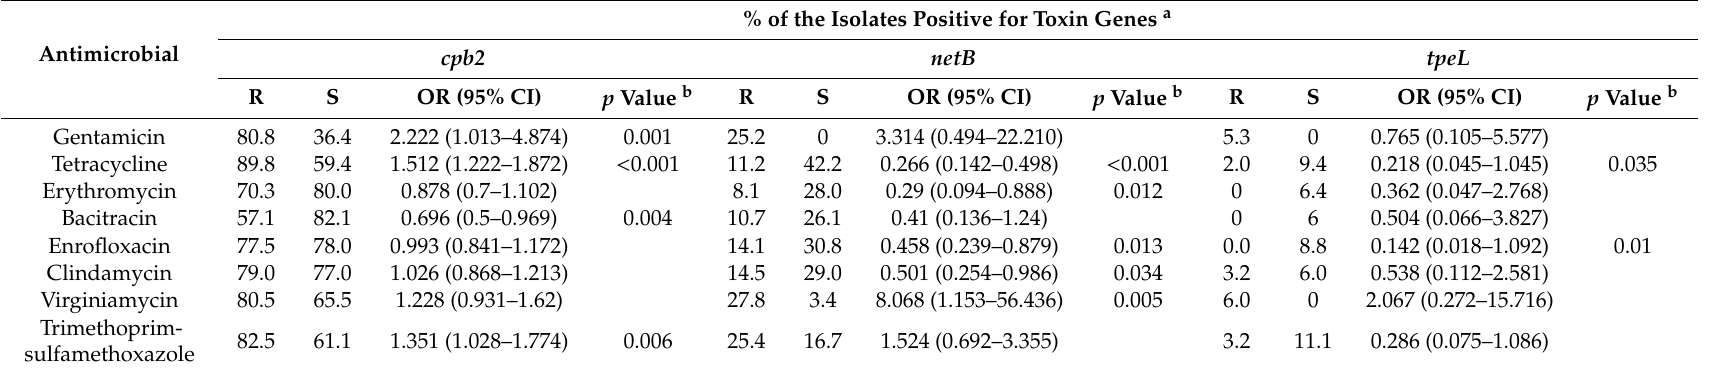
Table 4. Associations between antimicrobial resistance outcomes and the presence of toxin genes in C. perfringens isolates from chickens.